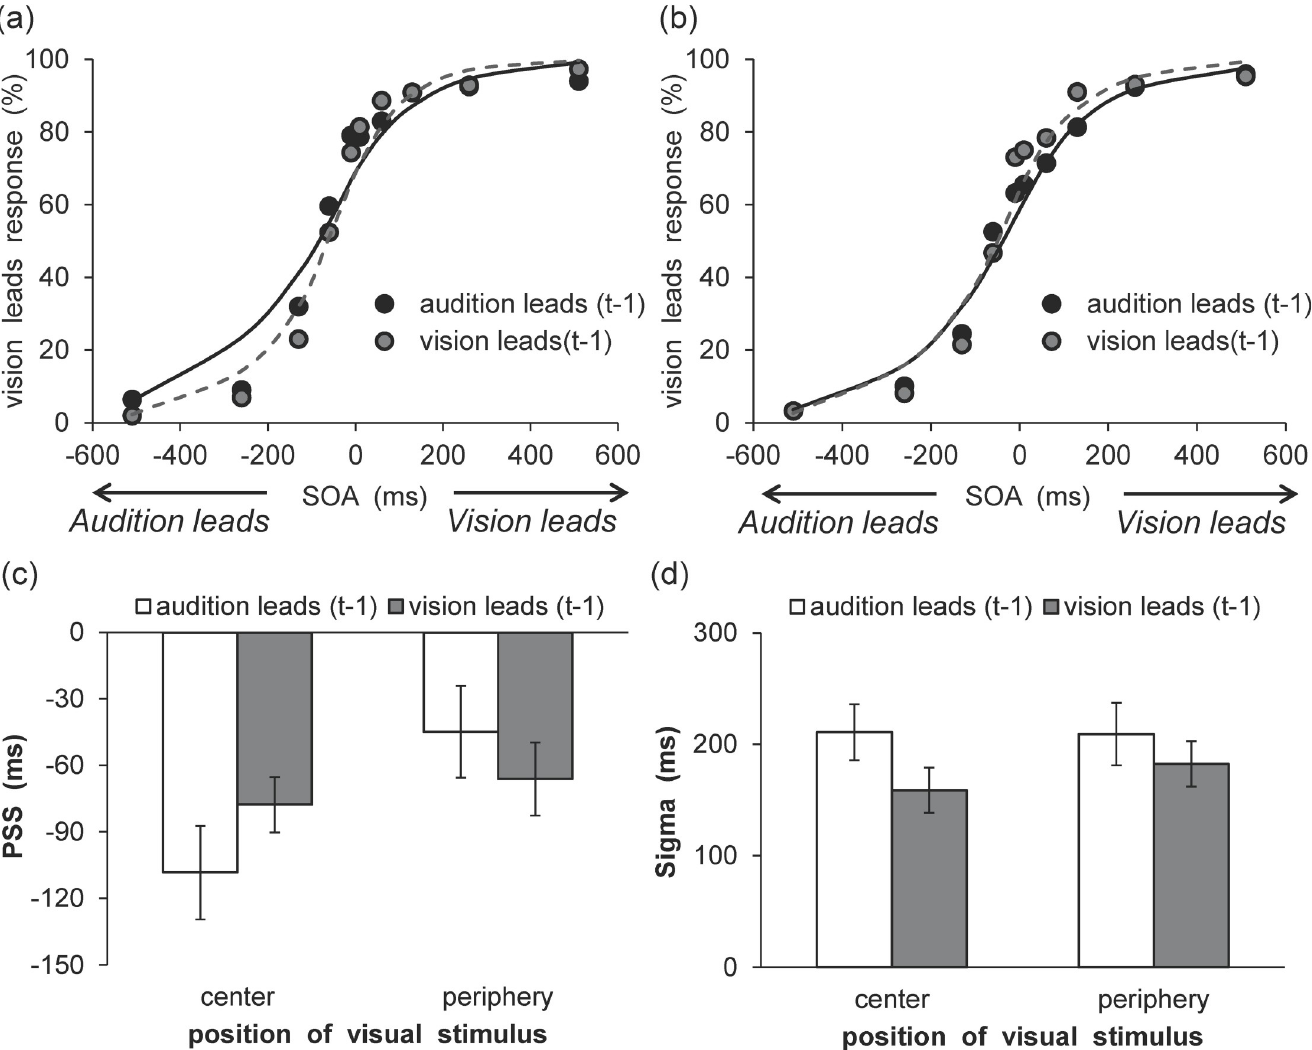
Fig 3. Results of rapid recalibration analyses in Experiment 1. Mean percentage of vision lead responses in the (a) central and (b) peripheral visual fields. The average fitting functions are plotted for preceding trials of audition leads and vision leads data. (c) Mean estimated point of subjective simultaneity. (d) Mean estimated sigma. Error bars represent standard errors of the mean ( n =